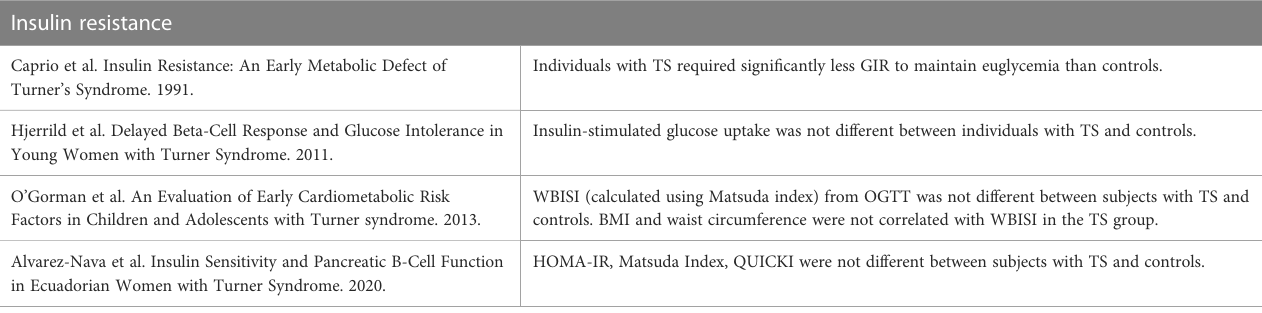
TABLE 5 Summary of key studies evaluating insulin resistance as a contributor to TS-associated hyperglycemia. Insulin resistance Caprio et al. Insulin Resistance: An Early Metabolic Defect of Turner ’ s Syndrome. 1991.